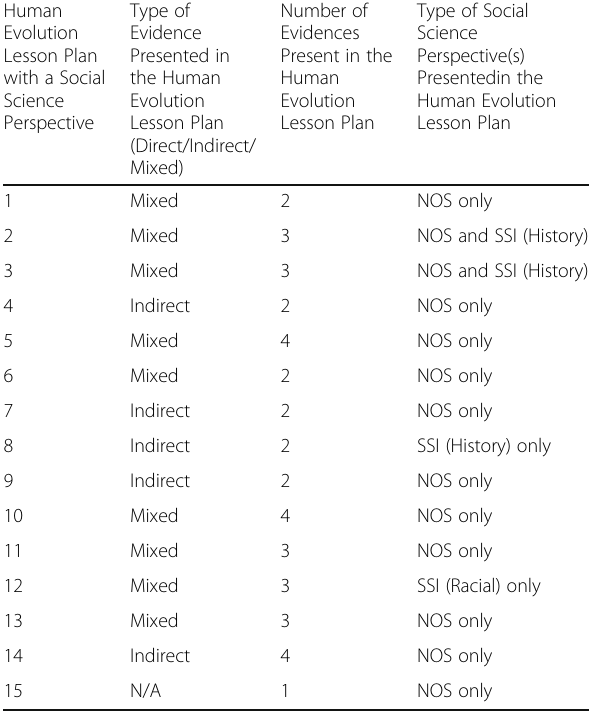
Table 4 Descriptive statistics of the 15 lesson plans containing a social science perspective Human Evolution Lesson Plan with a Social Science